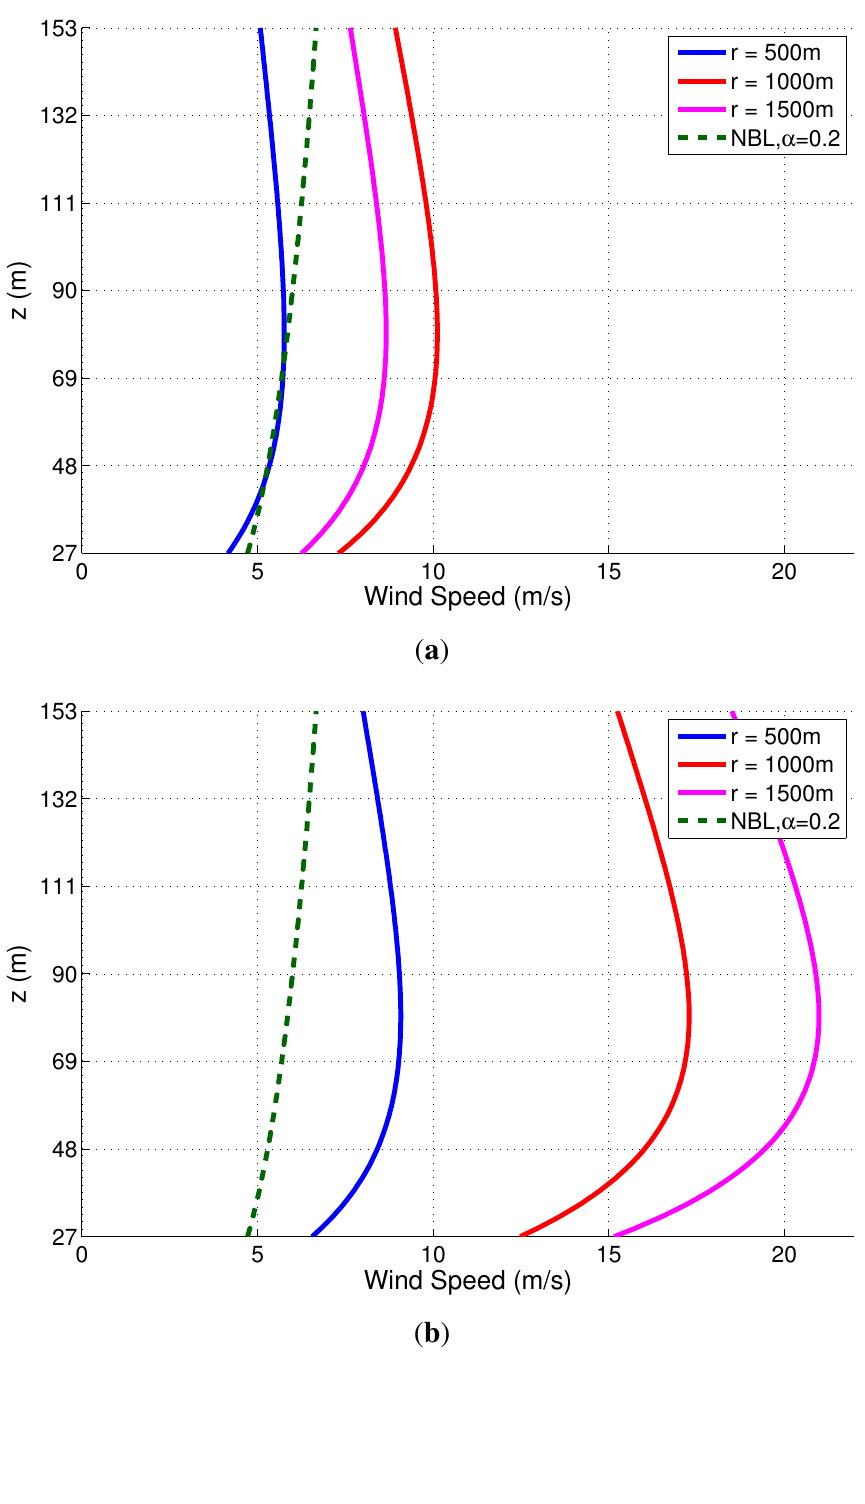
/ 6 when the storm intensity, d / 2 when the storm d